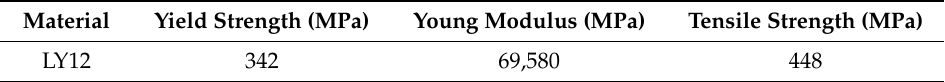
Table 1. The mechanical properties of